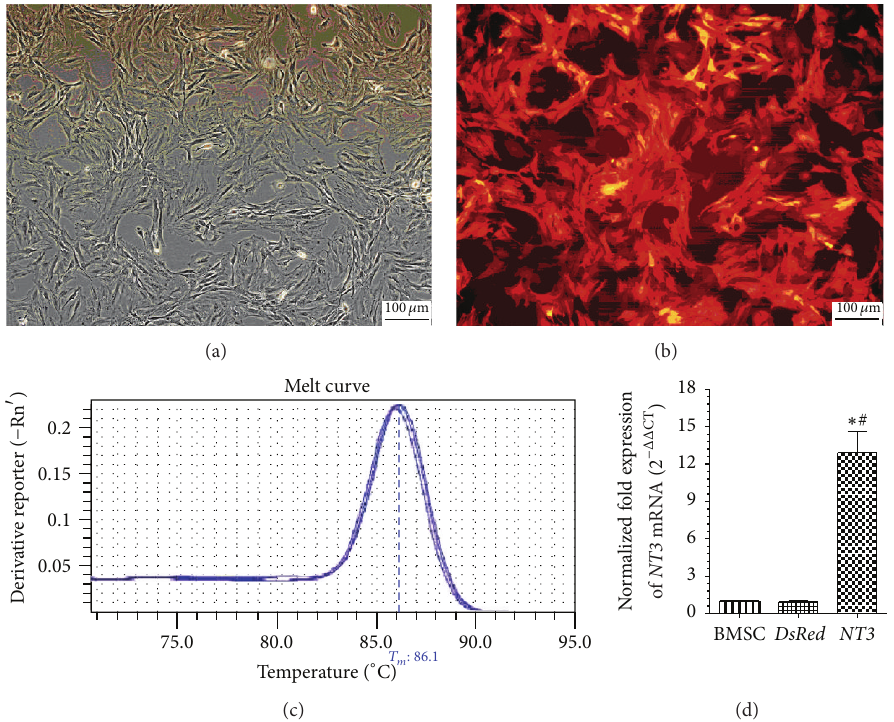
Figure1: Stabletransfection ofthe NT3-DsRed geneintoBMSCsusinga lentivirus((a),(b))and Q-PCTdetection of NT3 mRNA((c),(d)).(a) Before transfection. (b) After transfection. (c) NT3 mRNA Q-PCR melting curve. (d) The normalized fold change in NT3 mRNA expression